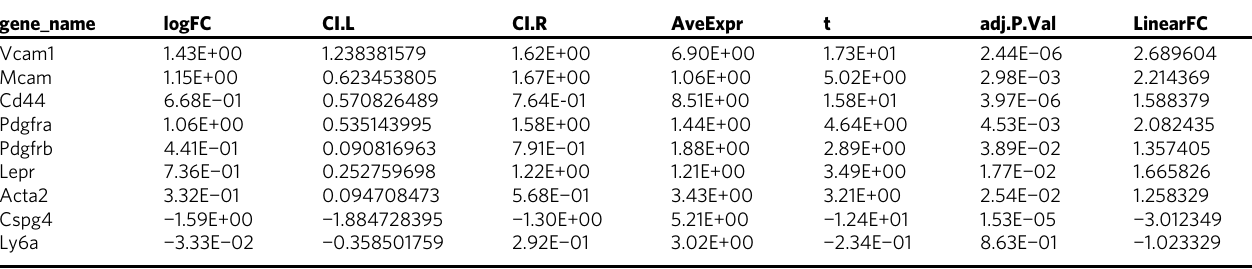
Table 1 Relative expression of MSC cell surface markers in Gli1+ MMPs over Gli1 − mesenchymal cells isolated from the chondro- osseous junction of one-month-old